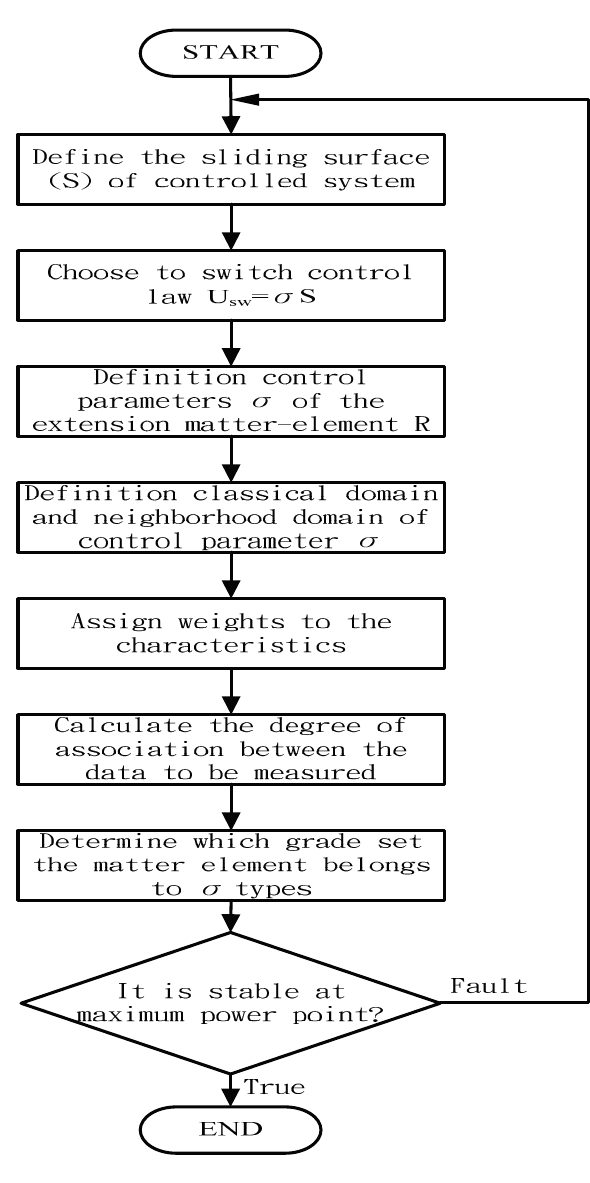
Figure 7. Extension Sliding Mode Control Flowchart of this